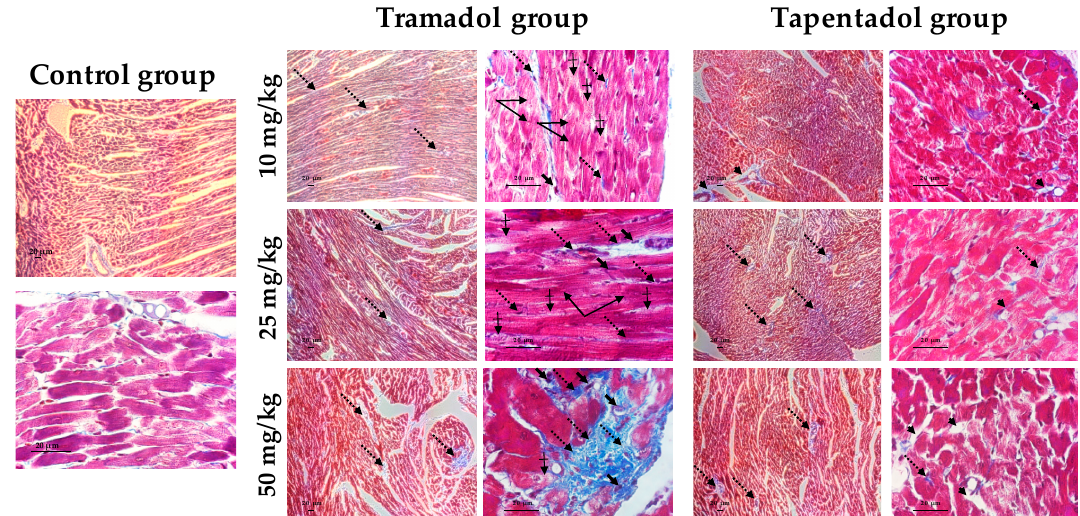
Figure 6. Photomicrographs of heart sections of Wistar rats intraperitoneally injected with different tramadol and tapen- tadol doses or saline (control group), for 14 consecutive days, upon hematoxylin and eosin (H&E) staining. A dotted stain- ing (vertical, crossed arrows), possibly denoting fibrous tissue deposition, is observed among cardiomyocytes. Mononu- clear inflammatory cells (inverted triangles) and altered cardiomyocytes (arrows), as well as loss of striation, are also